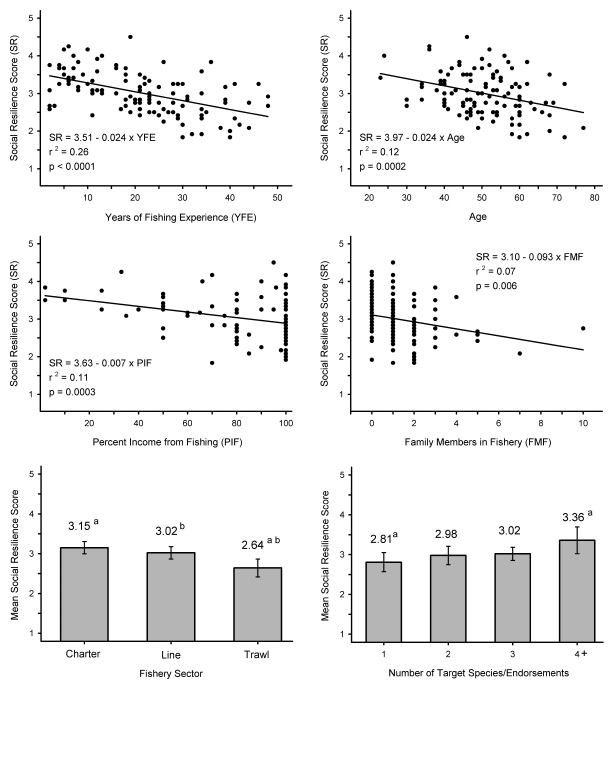
Fig. 1. Significant relationships between social resilience score and personal and fishing characteristic variables for the sample of Queensland commercial fishers. Category means with the same letter are significantly different ( p <